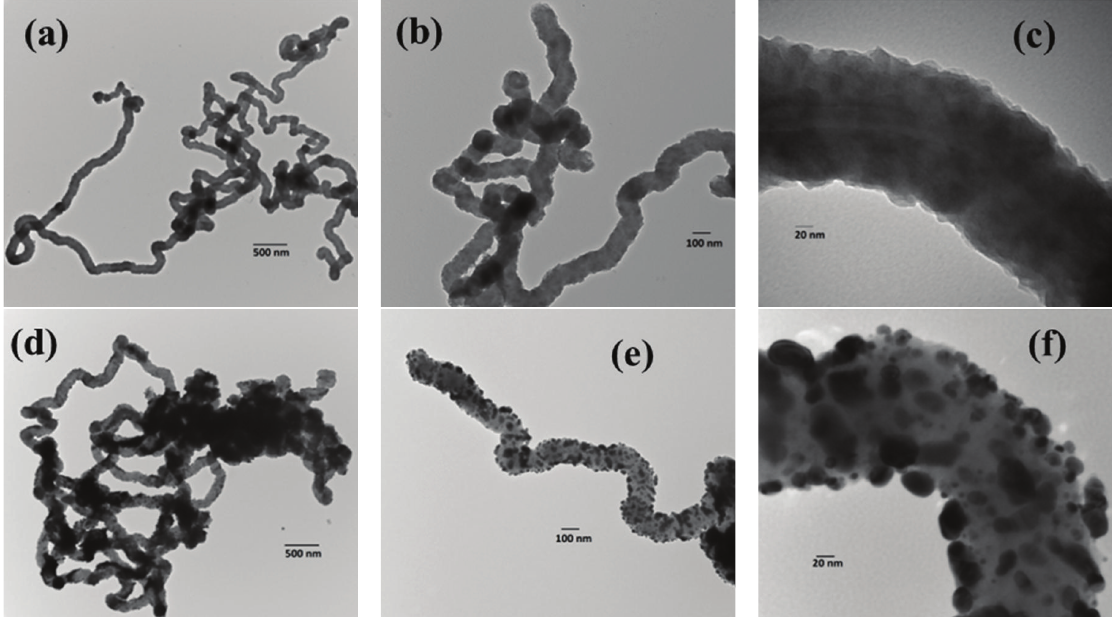
Figure 3: TEM images of CNTs/CoMoO 4 /silica (a, b, and c) and Pd/CNTs/CoMoO 4 /silica catalysts (d, e, and